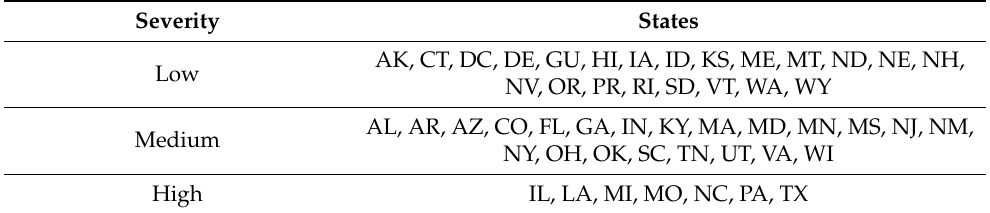
Figure 4. Cluster Figure 4. Cluster characteristics. Table 15. Cluster labeling.